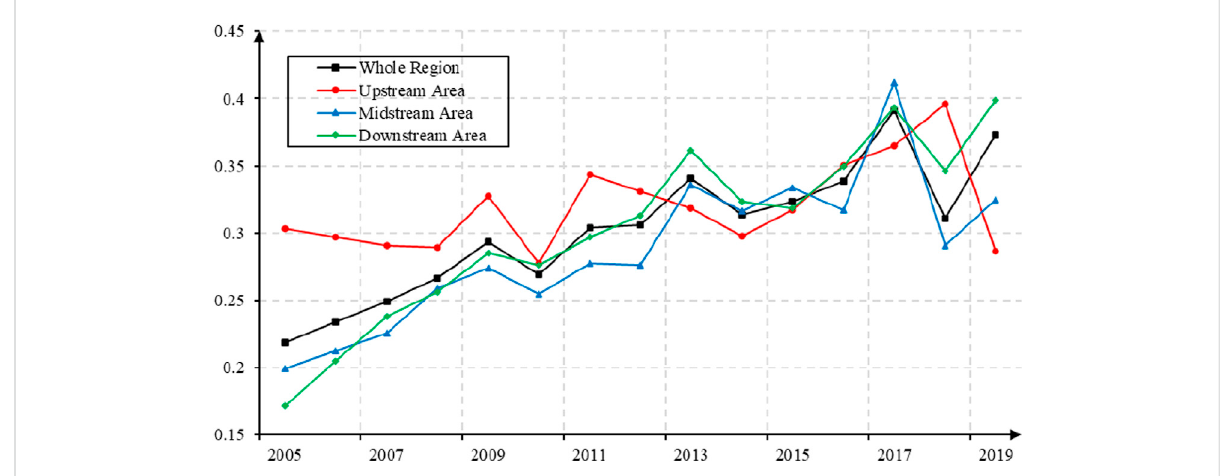
FIGURE 3 Time series trend of ULGUE in the Yangtze River Economic Belt measured by SBM model.